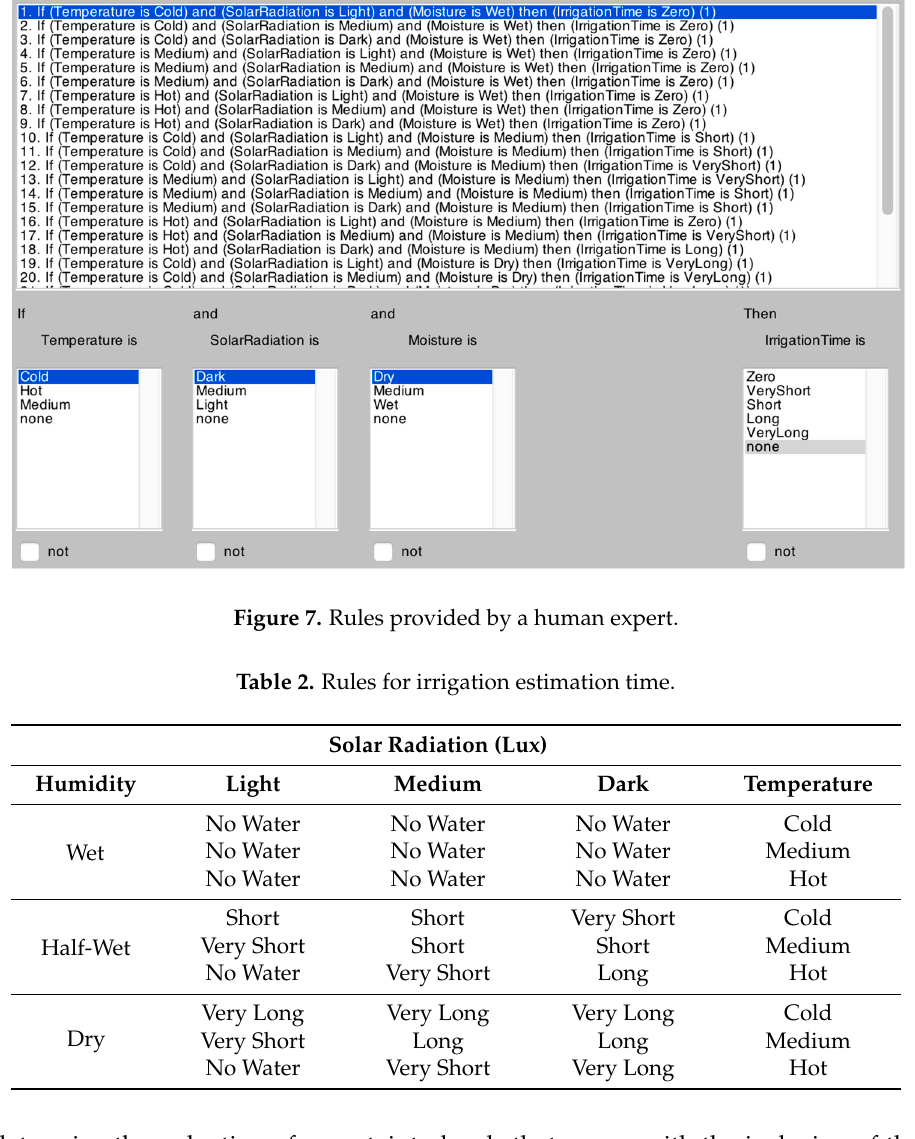
Table 3. Accuracy percentage (calculated with Bayes) depending on the irrigation levels, according to the variables indicated in Table 2.